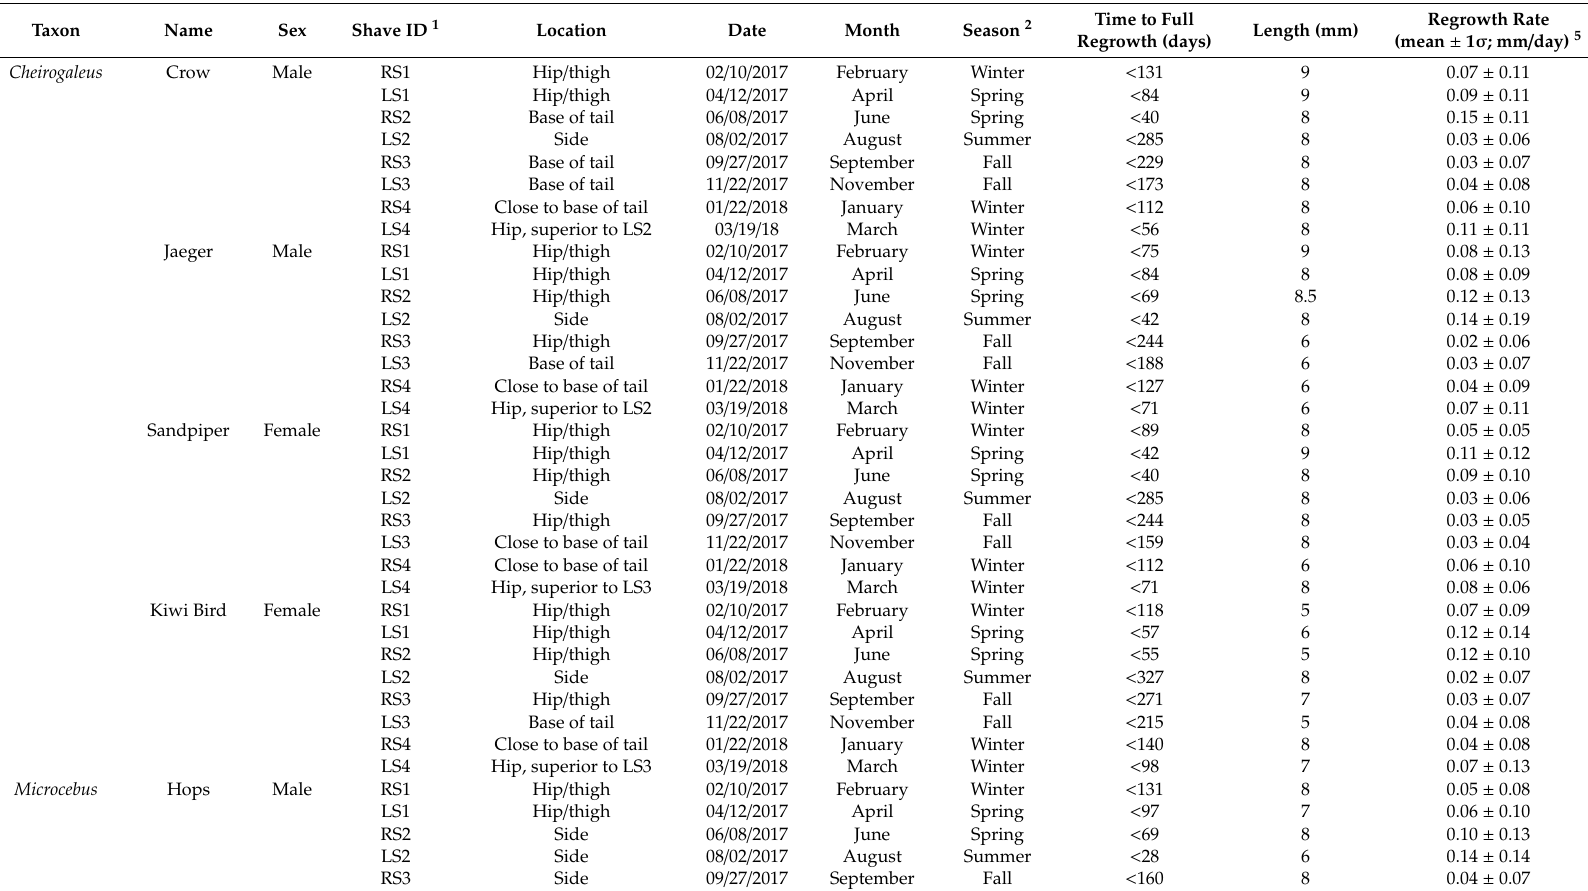
Table 2. Regrowth time for each shave for each individual. Dates are presented as Month / Day /